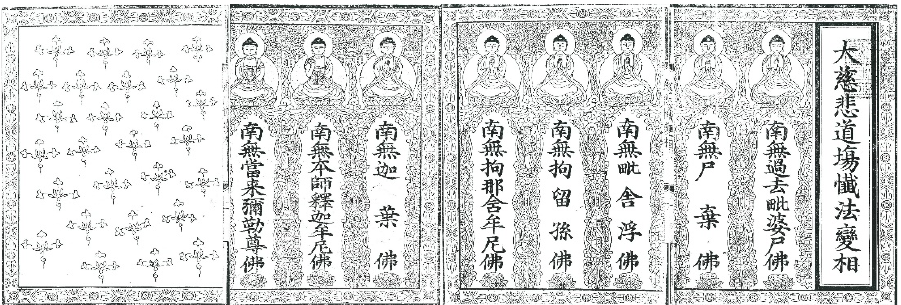
Figure 5. Sanggyojeong Edition of Repentance Rituals of the Great Compassion , Joseon dynasty (1474), 25.2 × 18.6 cm, National Library of Korea (Photo by National Library of Korea).